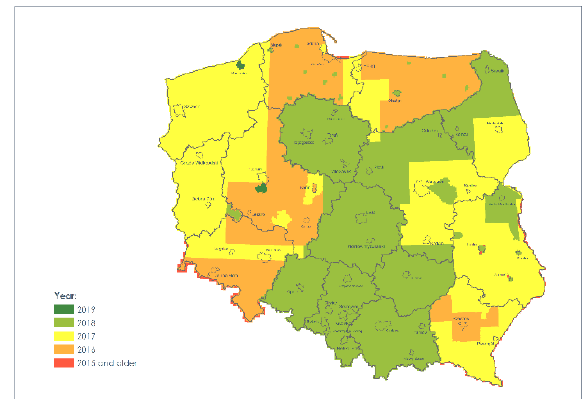
The figure 1. Actual state of latest orthophotomaps in national resource, state on the July 2019